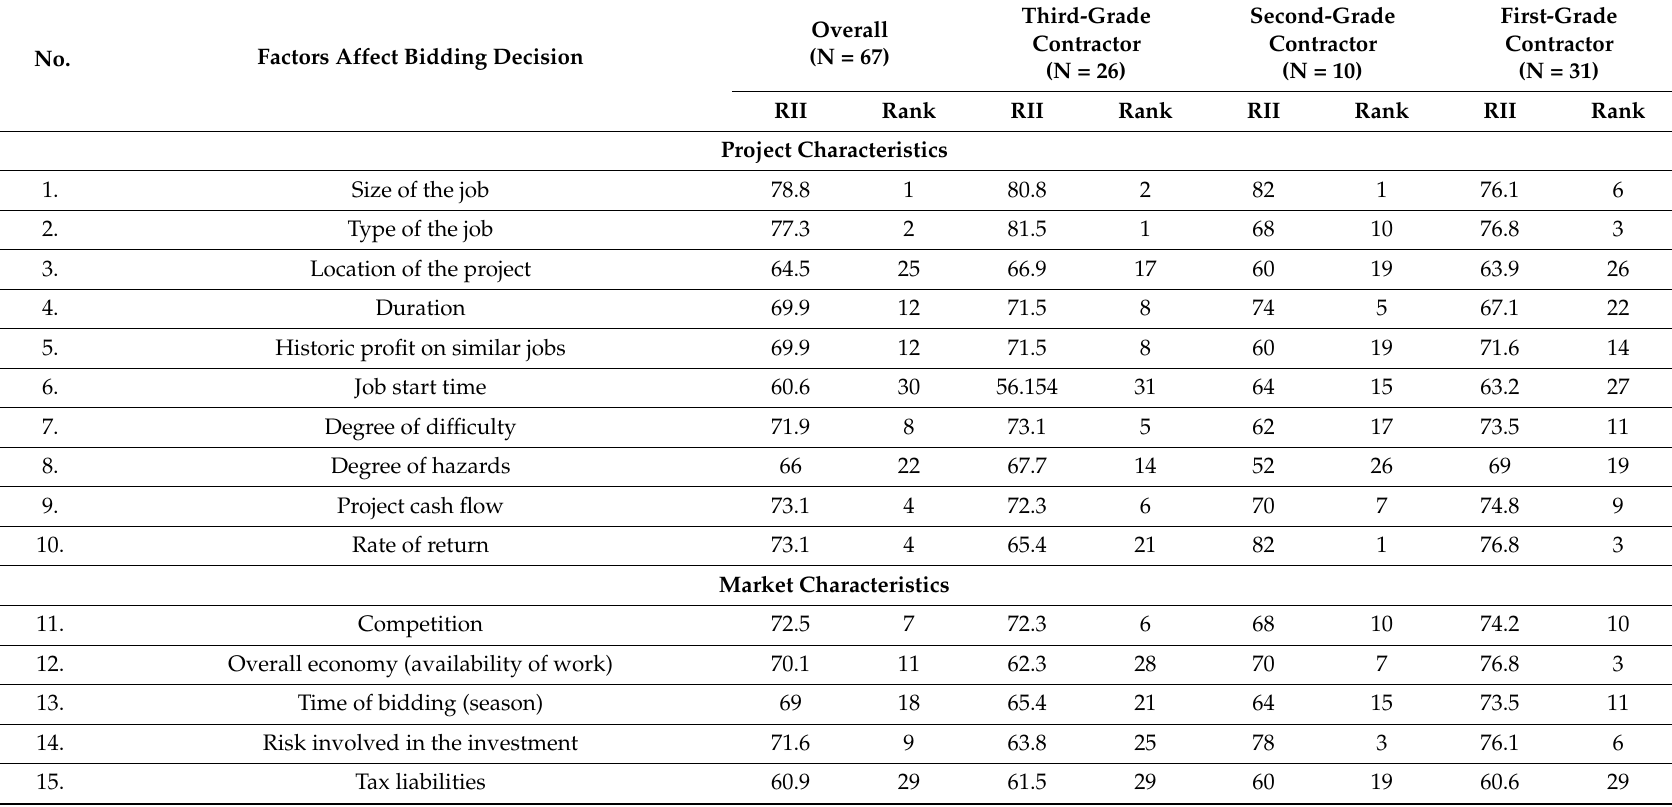
Table 1. Overall, third-grade, second-grade and first-grade contractors: RII and rank of factors affecting bidding decisions.